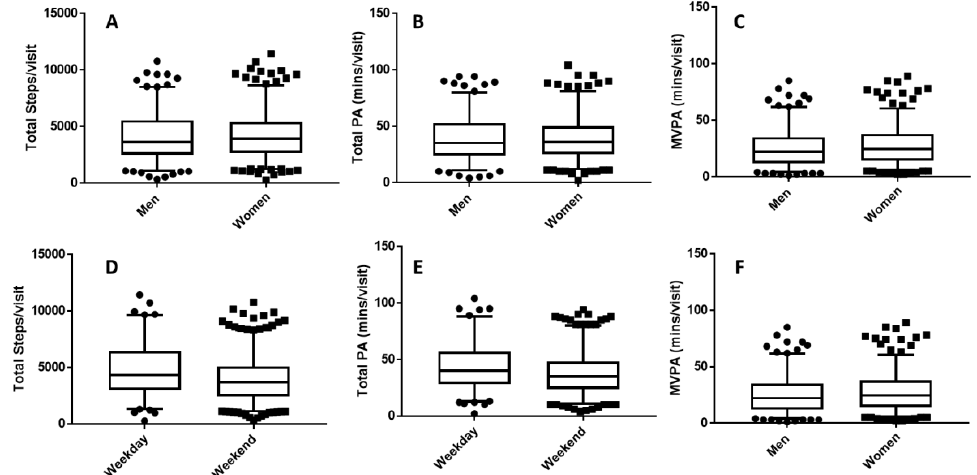
Figure 6. Objectively measured physical activity during a single visit to the frozen waterway trail. Data